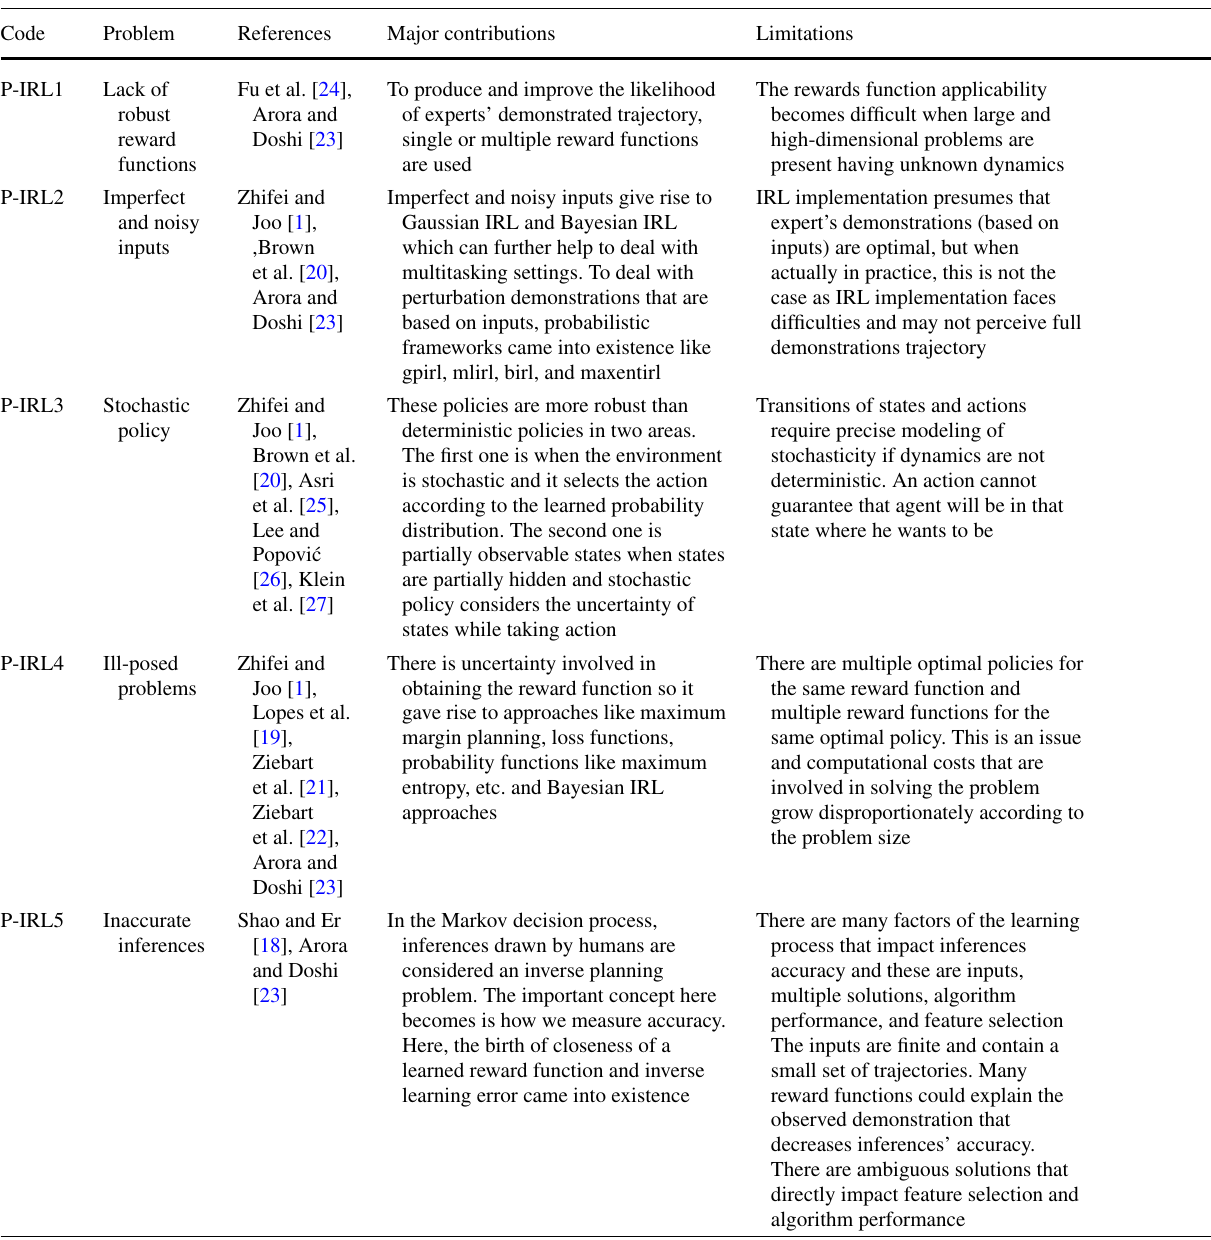
Table 1 Problems in the implementation of IRL Code